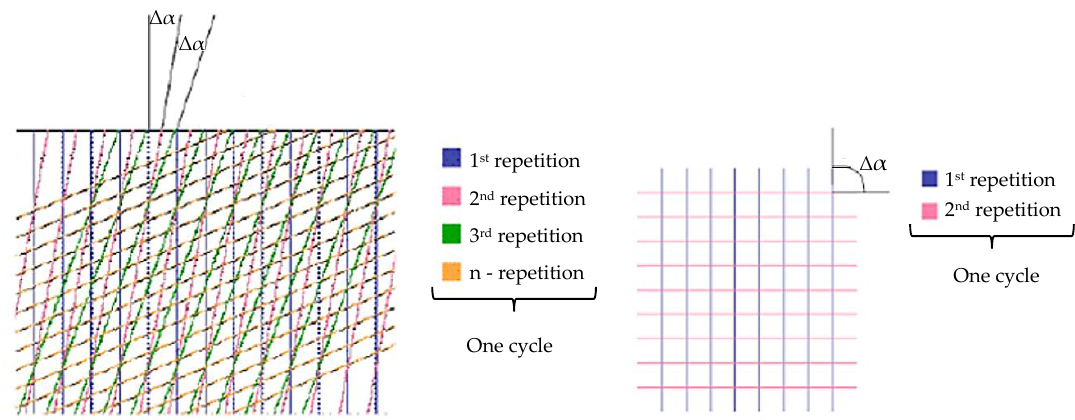
Figure 2. Laser treatment of ceramic surfaces: experimental set-up.